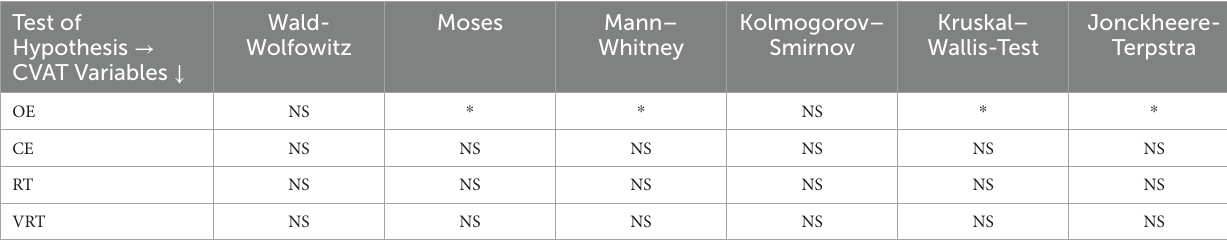
TABLE 4 Series of tests of hypothesis for data regarding the comparisons between modalities (online vs. face-to-face) using different individuals (between-subjects design). Test of Hypothesis → CVAT Variables ↓